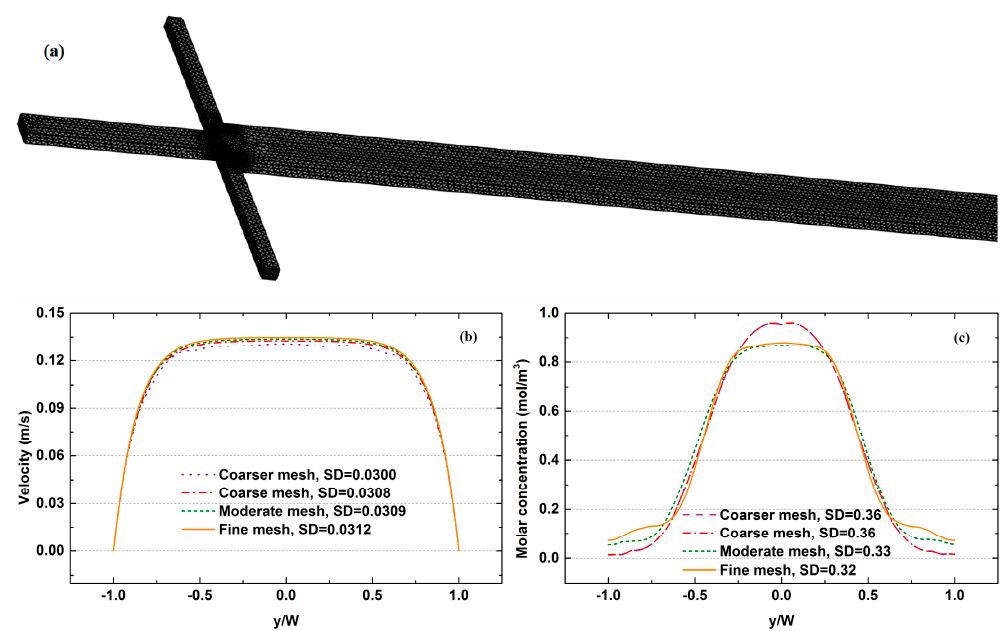
Figure 4. Grid independence verification: ( a ) the tetrahedral grid system used in this work; ( b ) velocity distribution; ( c ) molar concentration distribution.